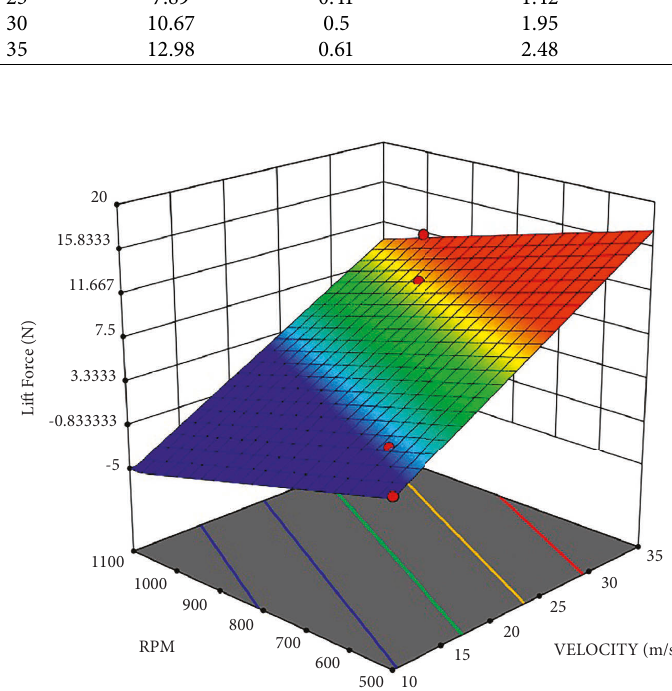
Figure 13: Lift force measured for the HH02 model.